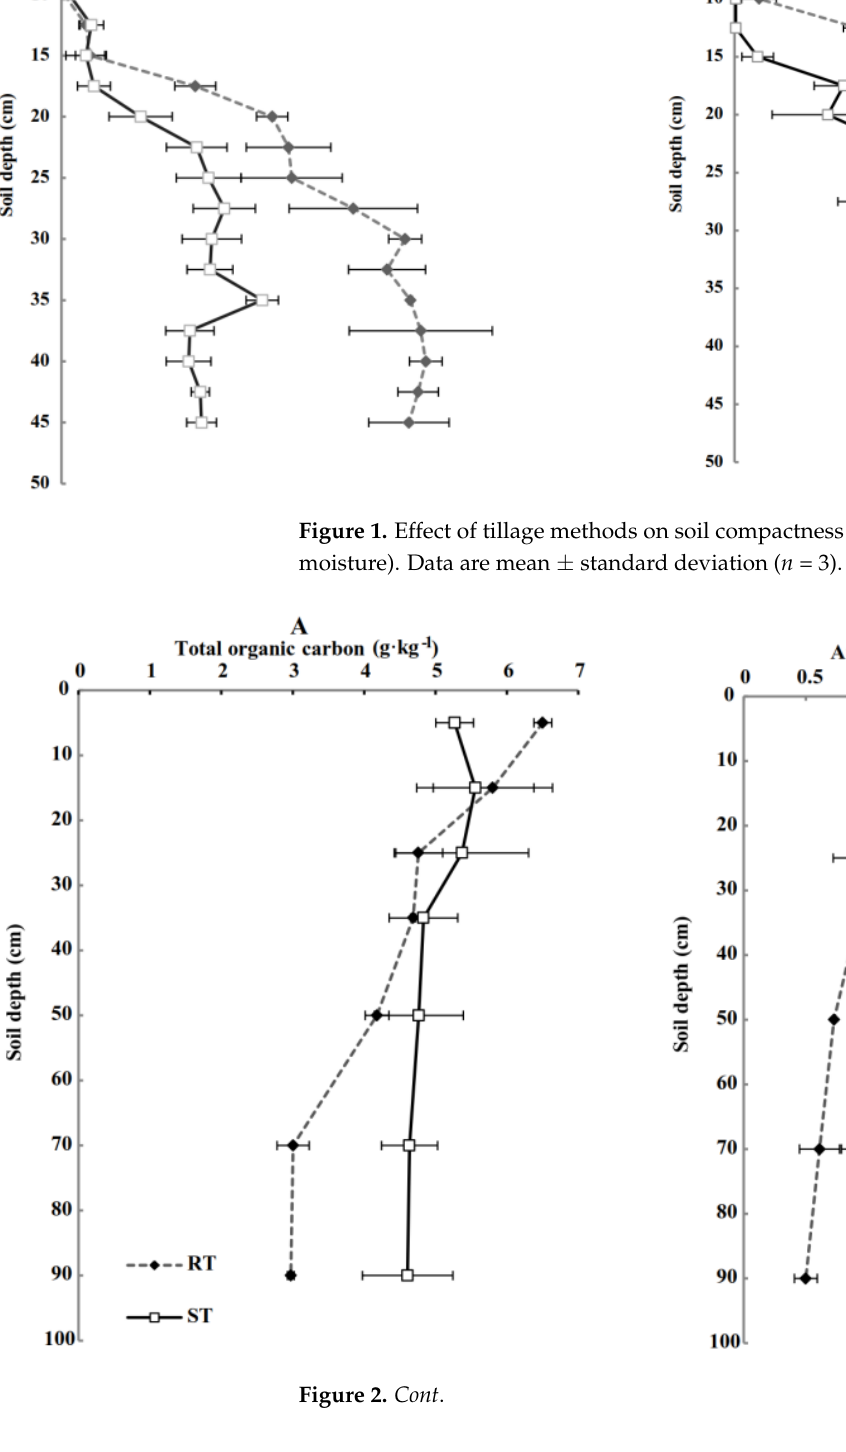
9 of 24 Figure 2. Effect of tillage methods on soil physicochemical property at 0–100 cm after harvest. ( A ) Total organic carbon; ( B ) Ammonium nitrogen; ( C ) Nitrate nitrogen; ( D ) Total nitrogen; ( E ) Volu- metric water content; ( F ) pH. Data are means ±±standard deviation ( n = 3). 3.2. Wheat Root Length Density in Soil Profile (0–100 cm) under Different Treatments As can be seen from Figure 3, from booting stage to flowering stage, the density of root length at each depth showed a trend of gradual increase, reaching the maximum at flowering stage. The difference in root length density between different treatments reached the maximum at booting stage and began to decrease at flowering stage. The root density decreased logarithmically with the increase in soil depth. At the booting stage of winter wheat (Figure 3A), the root length density of ST treatment was significantly higher than that of RT ( p < 0.05) at all depths (2.85 times higher on average) when the soil depth was over 70 cm. In the deep soil below 70 cm, the differences between the two treatments in each depth gradually decreased, and the two lines overlapped. After entering the flow- ering stage (Figure 3B), the root development of winter wheat in each treatment was ma- ture. The root length density of ST treatment was still significantly higher than that of RT. However, the difference in root length density between the two treatments at 0–60 cm was gradually reduced, which was 1.55 times higher on average than that at booting stage. However, in the soil below 60 cm, the difference between the two treatments at each depth increased significantly ( p < 0.05), and the root length density of ST treatment increased 4.80 times that of RT on average. This indicates that subsoiling + rotary tillage can promote the root system to go down to the depth, accelerate the root growth in both horizontal and vertical directions and is conducive to improving the utilization rate of subsoil resources.